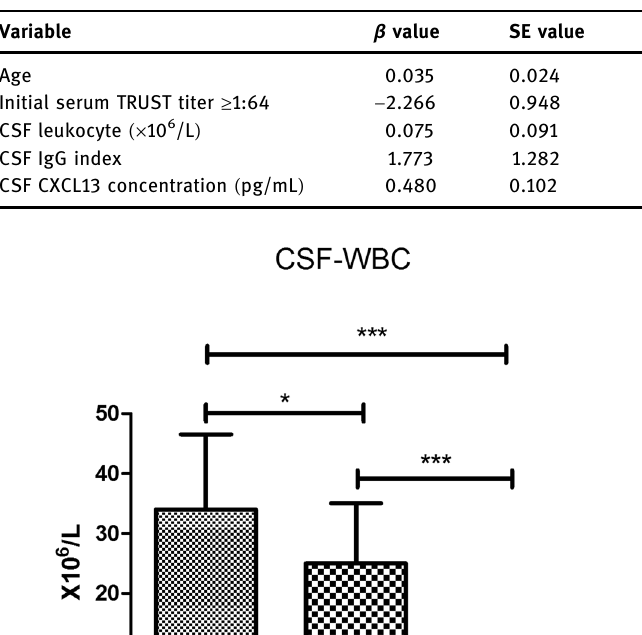
Table 4: Multivariate binary logistic regression analysis